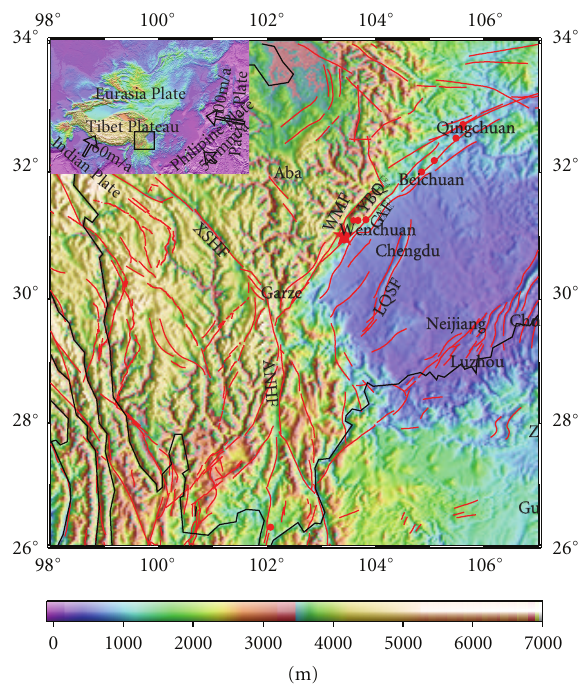
Figure 1: Geological setting. WMF is Wencuan-Maoxian fault, YBQF is Yingxiu-Baichuan-Qingchuan fault, GAF is Guanxian- Anxian fault, XSHF is Xianshuihe fault, ANHF is Anninghe fault, and LQSF is Longmenshanfault. The red circles represent the main- and aftershockswith magnitude greater than 6.0. The red lines show the active faults based on [2]. The inset map shows relative plate motion and the location of our study area. The black arrows show direction and magnitude of plate movements relative to the fixed Eurasian plate, and the black box shows the location of our study area, the western Sichuan province,